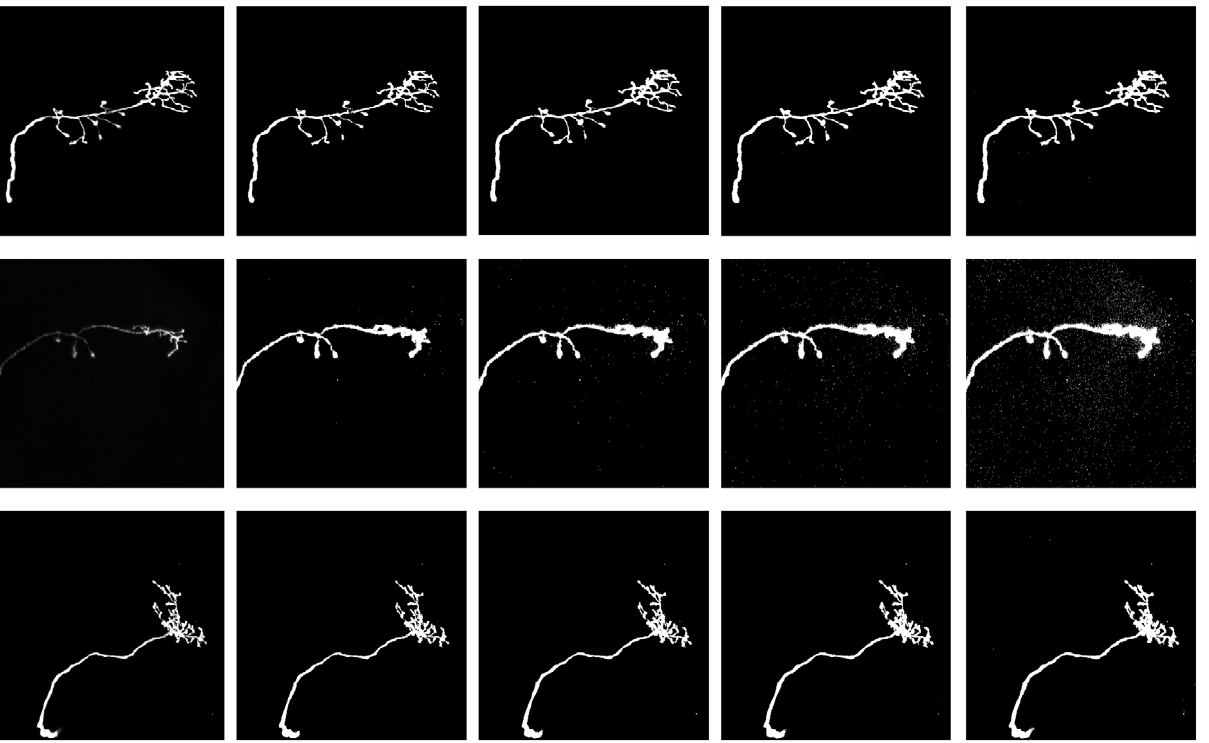
Figure 9. Three data of OlfactoryProjectionNeuron in the DIADEM data set are used to demonstrate the binarization method. The neurons are rendered by the maximum intensity projection (MIP) method. Every row shows a neuron undergoing different levels of binarization. From left to right, they are the original neuron image followed by the binarized results. From the second column to the last column, we kept 50%, 60%, 70%, and 80% of the brightest visible voxels where the visible voxels are voxels having a gray scale above 10. In the proposed method, we keep 70% of the brightest visible voxels, which are shown in column 4.